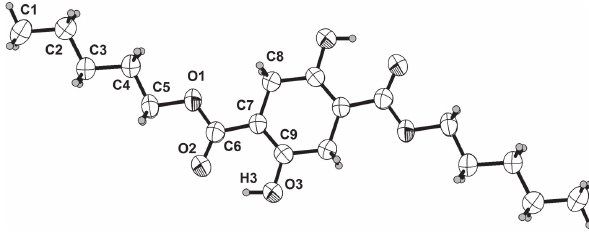
Table 1: Data collection and handling.